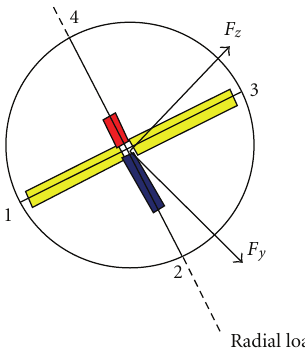
Figure 16: Expected orientation of F y and F z , and the blades (1.18 N Q n , ref